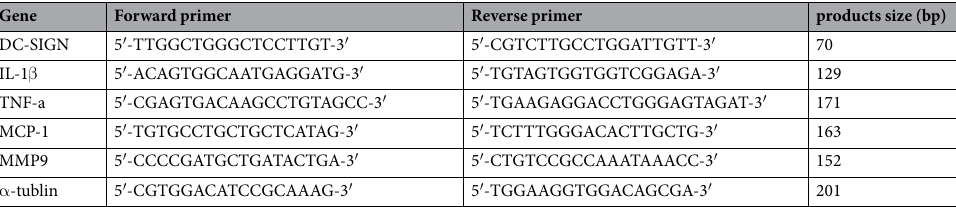
Table 2. The primer has been used for Real-time